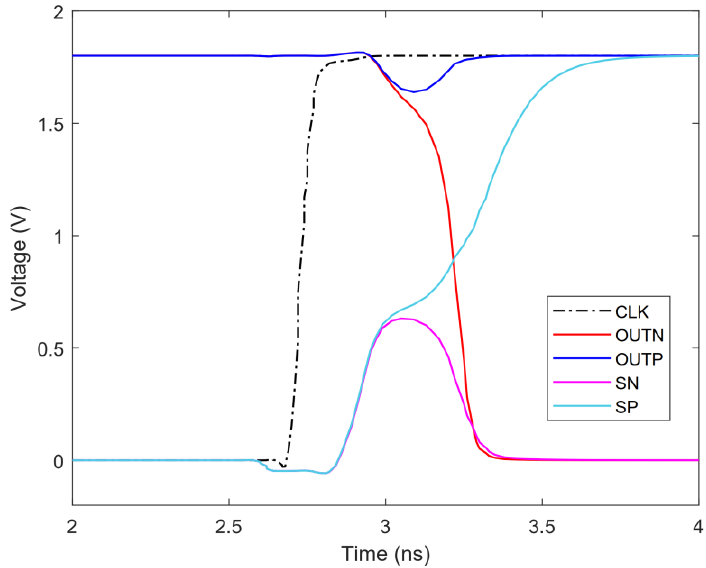
Figure 12. Transient simulation of comparator.